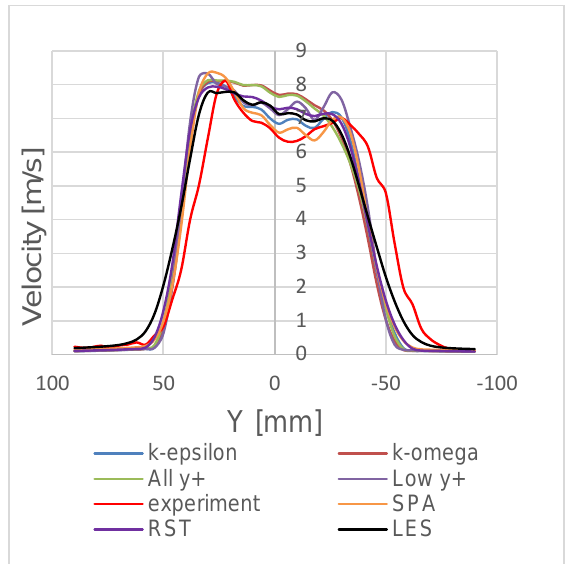
Fig. 8. The v elocity profiles